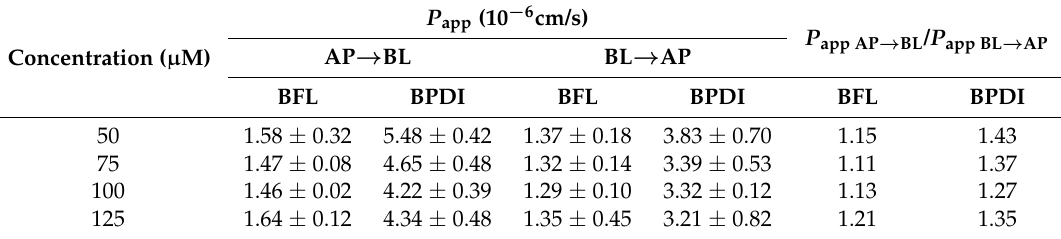
Table 2. The apparent permeability coefficient ( P app ) values of bi-directional transport of BFL and BPDI with different